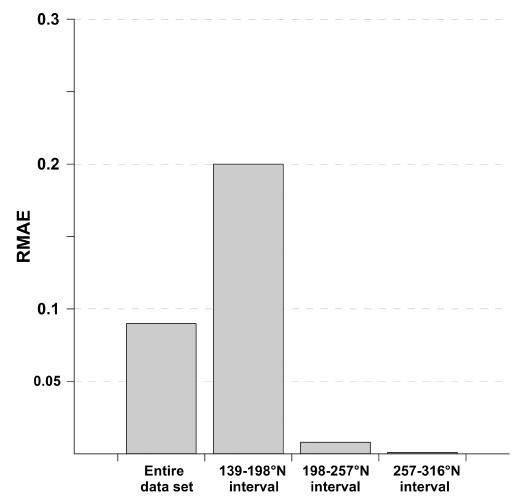
Figure 4. Validation of the SWAN model using RMAE values cal- culated both for the entire data set and for three wave direction in-